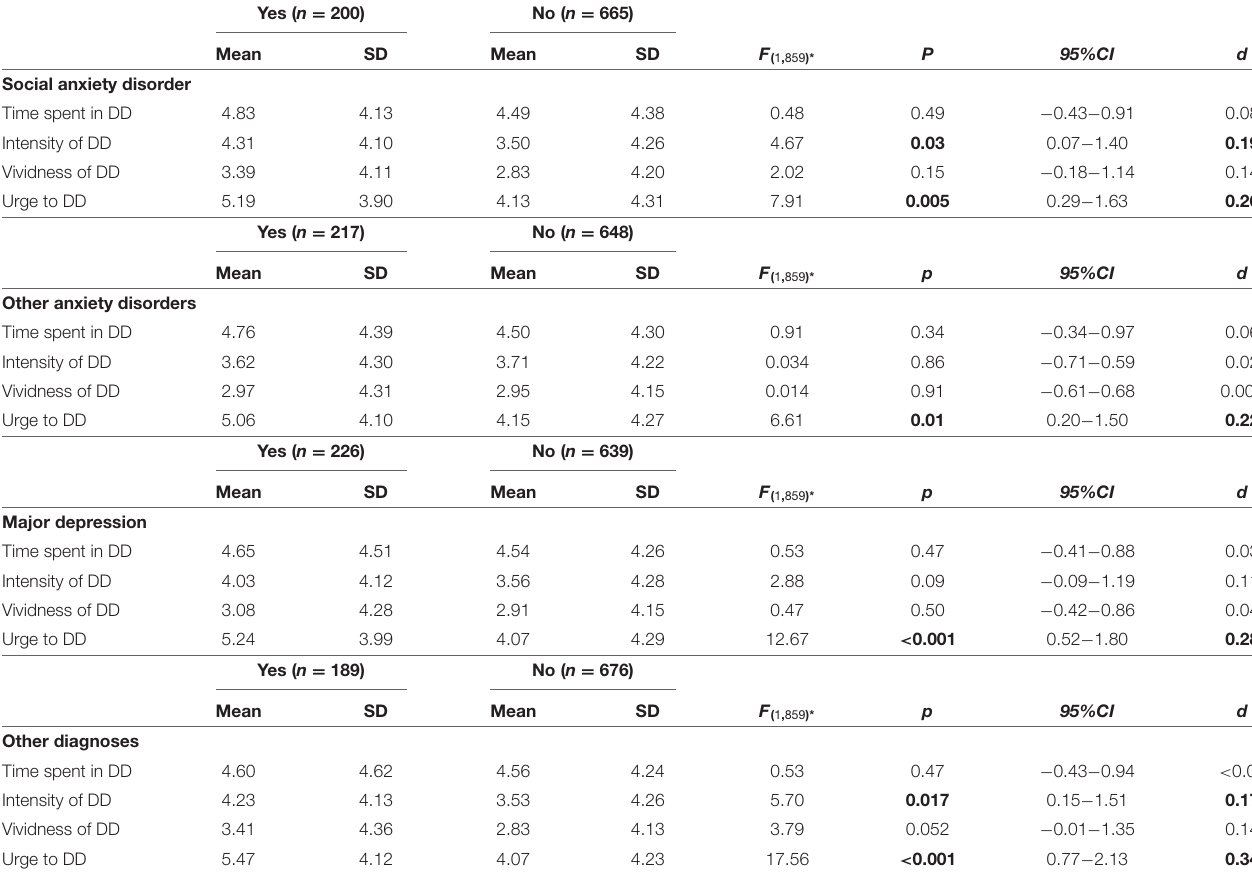
TABLE 2 | Post–hoc ANCOVA results of the relationships between comorbidities and DD indices. Yes ( n = 200) No ( n = 665) Mean SD Mean SD F ( 1 , 859 )* P 95%CI